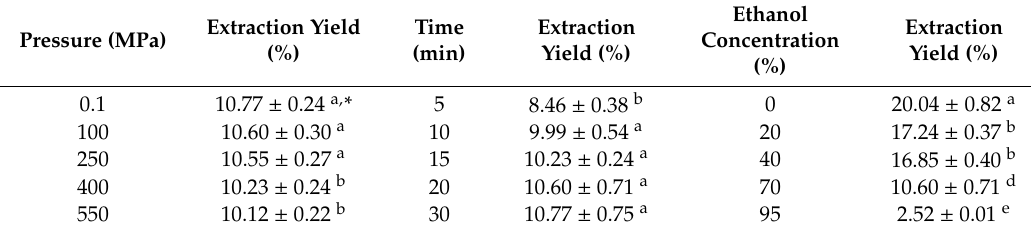
Table 1. High hydrostatic pressure extraction (HHPE) yield of ground turmeric. Pressure